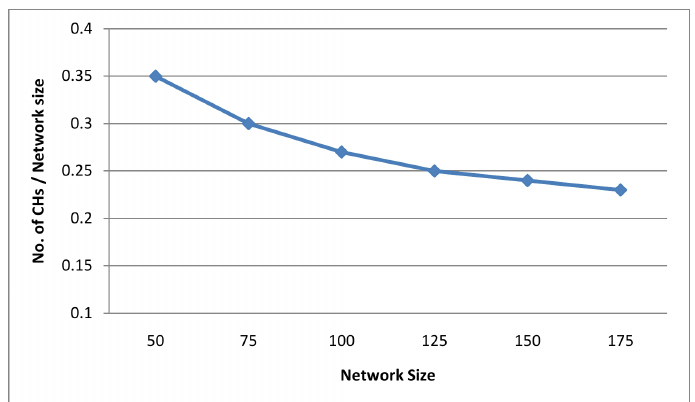
Figure 11. Density of Cluster Heads vs Network